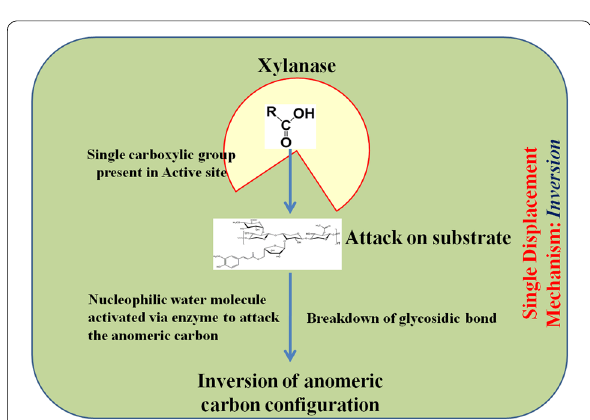
Fig. 3 Mode of action of xylanase: